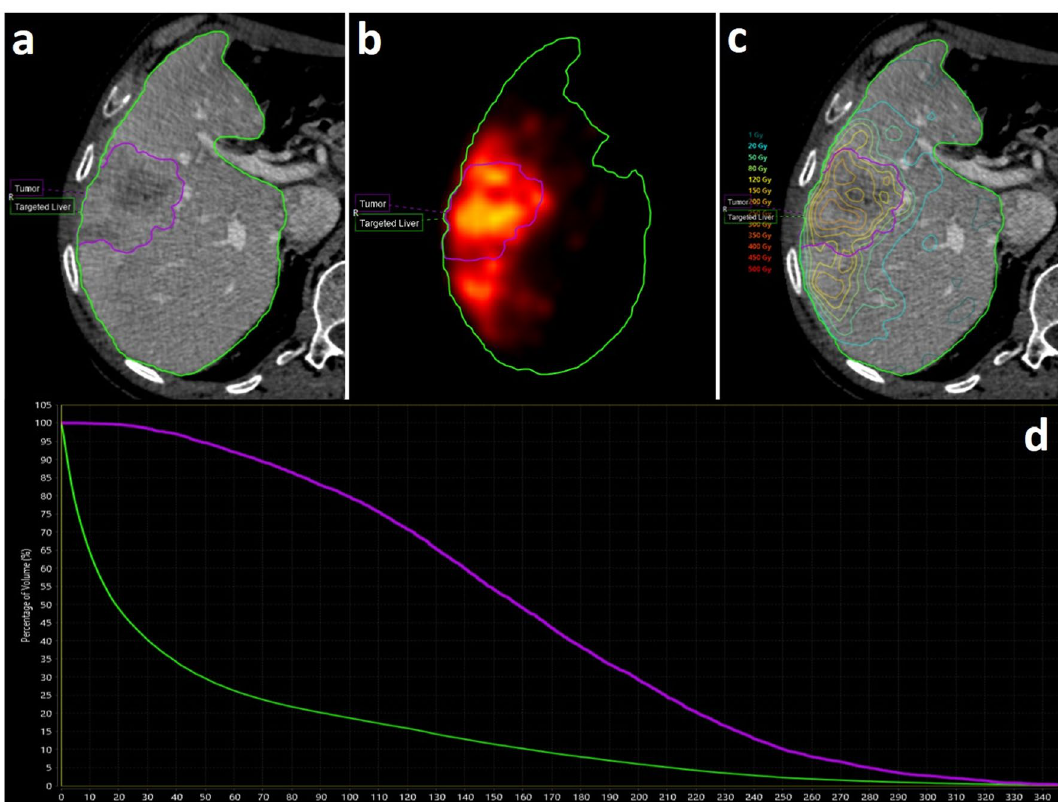
Figure 1. A representation of imaging processing by using the dosimetry software (Simplicit90Y, Mirada Medical, Oxford, UK). On upper left panel ( a ), VOIs semi-automatically defined on the contrast-enhanced CT over the targeted liver and tumor. On upper central panel ( b ), the same VOIs transferred over the previously co-registered 90 Y-PET. On upper right panel ( c ), calculated isodose distribution within the targeted liver and tumor. On bottom panel ( d ), dose-volume histograms (DVH) of the targeted liver and